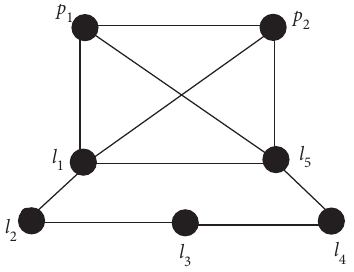
Figure 4: The graph in which β